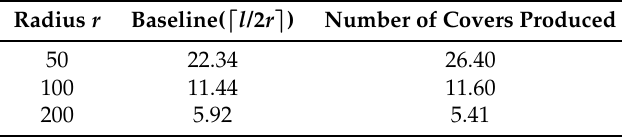
Table 5. Experiments on the minimum cover with a range constraint ( l ≈ 2183.5, w = 30).